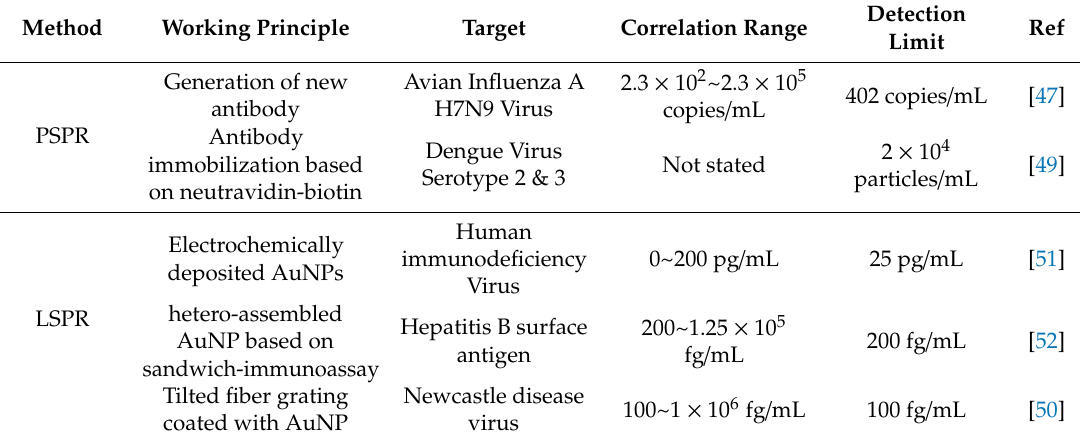
Figure 4. LSPR-based immunosensors for viral agent detection. ( a ) Detection of HIV-1 virus by LPSR-based immunosensor; ( b ) signal amplification of LSPR-based immunosensor by forming hetero-assembled gold nanoparticles based on the sandwich assay. ( a ) Figure reproduced with permission from [51], © 2013 Elsevier, ( b ) Figure reproduced with permission from [52], © 2018 Elsevier. Table 2. Comparison of SPR and LSPR-based immunosensors for viral agent detection.